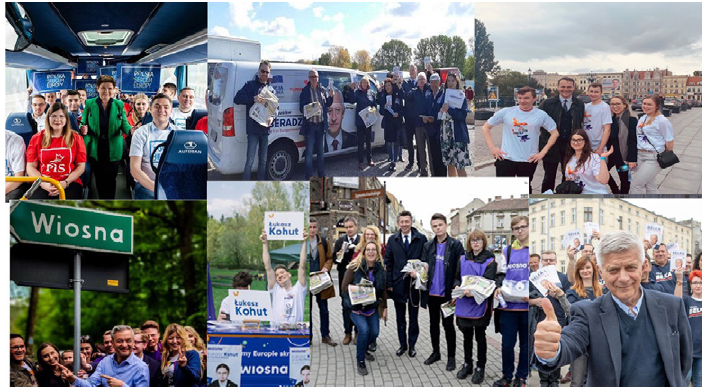
Figure 4. Photos of candidates with “the team” ( topos of the charismatic leader) (source: Instagram )